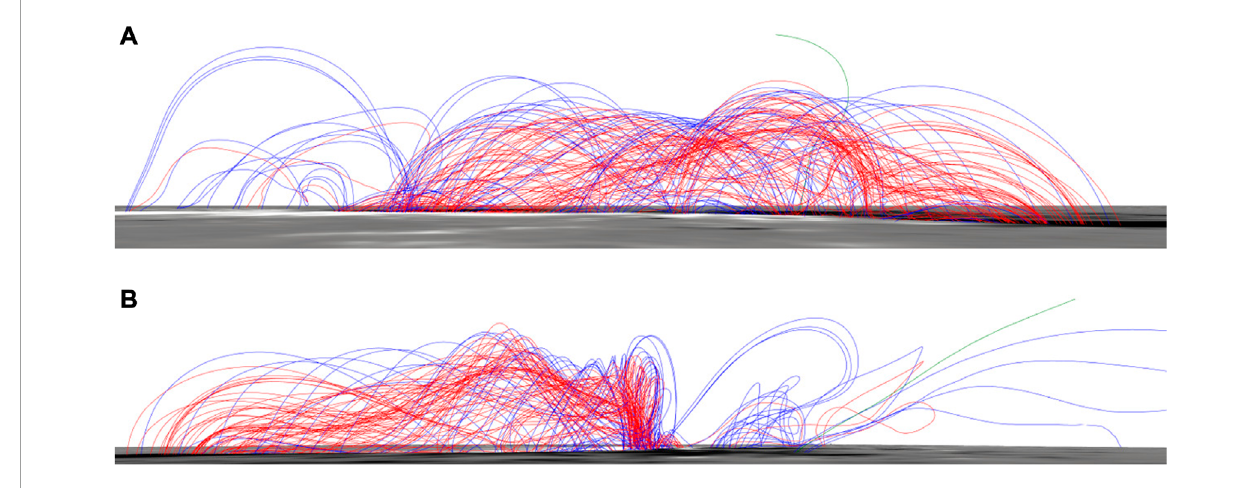
FIGURE 7 The xz-plane (A) and yz-plane (B) views of the 00:00UT OR data volume.